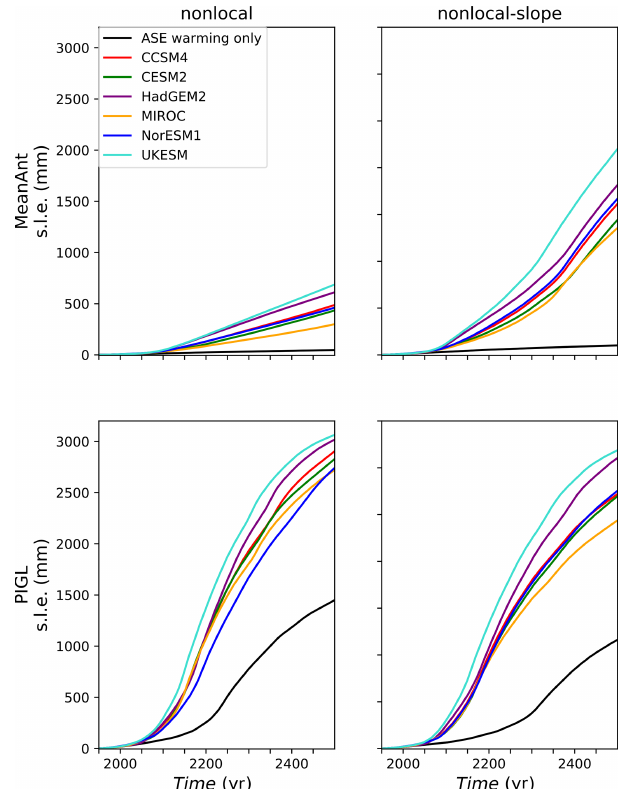
Figure 21. Sea-level rise (mms.l.e.) from Antarctic ice loss in 550- year experiments with a Coulomb friction law ( p = 1) and with δT sector = 0 for the Amundsen sector to represent a 2 ◦ C anomaly relative to the spin-up. Black lines show SLR for experiments with- out ESM ocean forcing anomalies, so that the response is limited to the Amundsen sector. The other lines show SLR for experi- ments with ESM ocean forcing anomalies in addition to the 2 ◦ C Amundsen anomaly. The four panels correspond to the nonlocal and nonlocal-slope melt parameterizations with the MeanAnt and PIGL